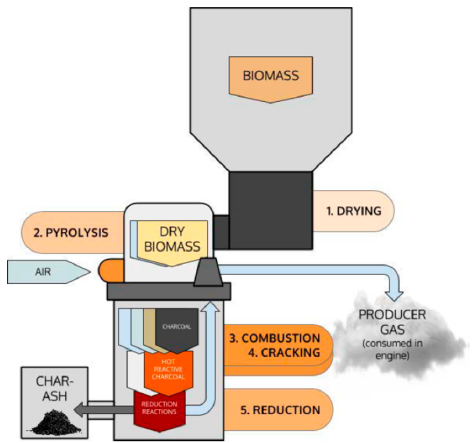
Figure 2. Schematic view of the gasifier system.